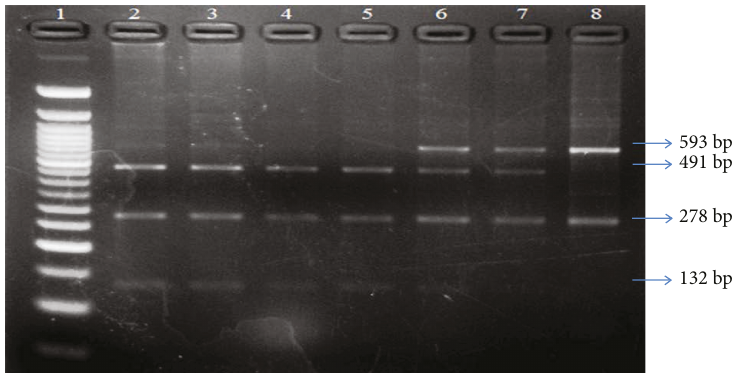
Figure 1: Representative gel picture showing Msp I-digested amplicons of XRCC1 codon 399 run on 3% agarose gel. Lane 1: 50 bp DNA ladder. Lanes 2, 3, 4, and 5: 132bp, 278 bp, and 461 bp Arg/Arg genotype. Lanes 6 and 7: 132 bp, 278 bp, 461bp, and 593bp Arg/Gln genotype. Lane 8: 278bp and 593bp Gln/Gln genotype.